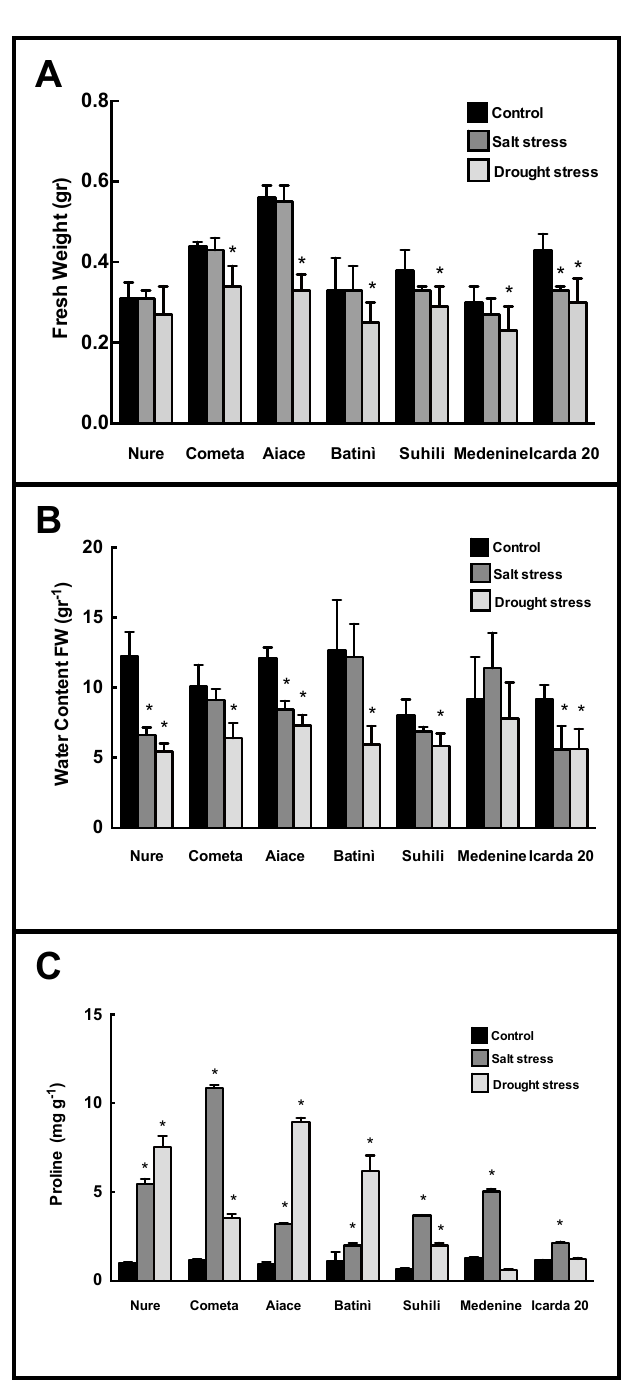
Figure 5. The changes in ( A ) Fresh weight; ( B ) Relative water content (RWC) and ( C ) Proline levels, in leaves of selected barley genotypes in control condition (black bars), Salt stress (NaCl 150 mM) (dark grey bars); and drought (PEG 10%) (light grey bars). The asteriks (*) indicate p value ≤ 0.001.